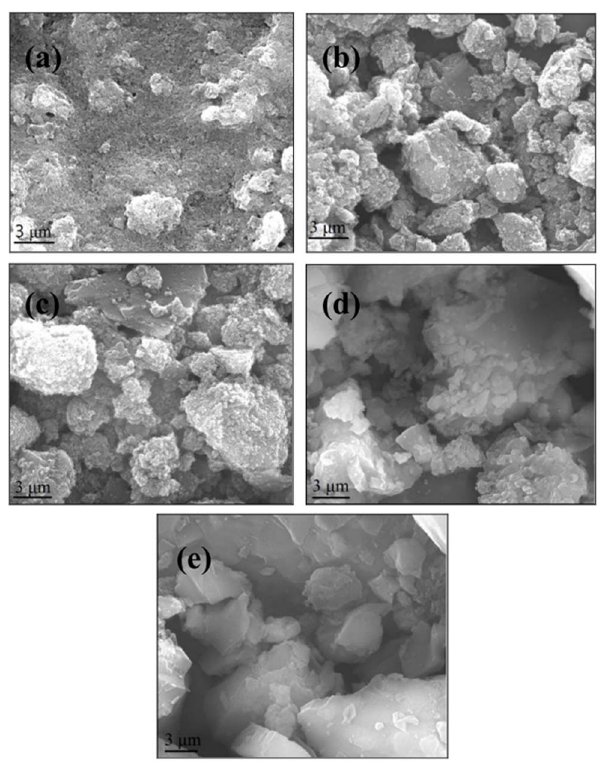
Figure 3. SEM images of (a) uncalcined Fe 3 O 4 -HBC composite, (b) 400 6 C under air, (c) 400 6 C under nitrogen, (d) 1000 6 C under air, (e) 1000 6 C under nitrogen.